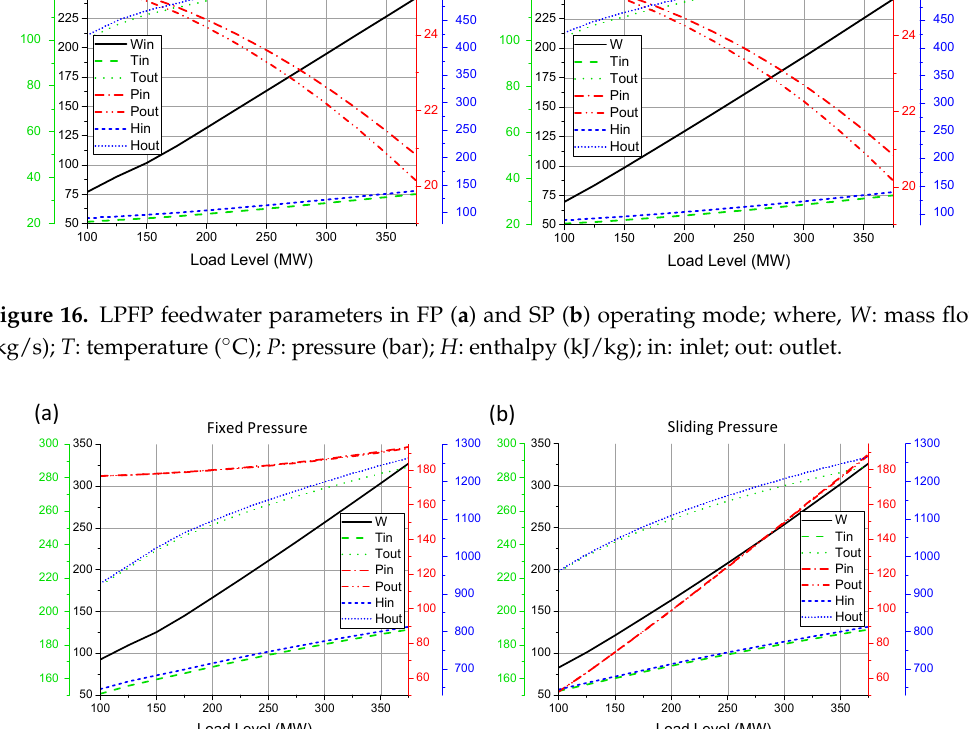
Figure 17. HPFP feedwater parameters in FP ( a ) and SP ( b ) operating mode; where, W : mass flow (kg/s); T : temperature (°C); P : pressure (bar); H : enthalpy (kJ/kg); in: inlet; out: outlet.